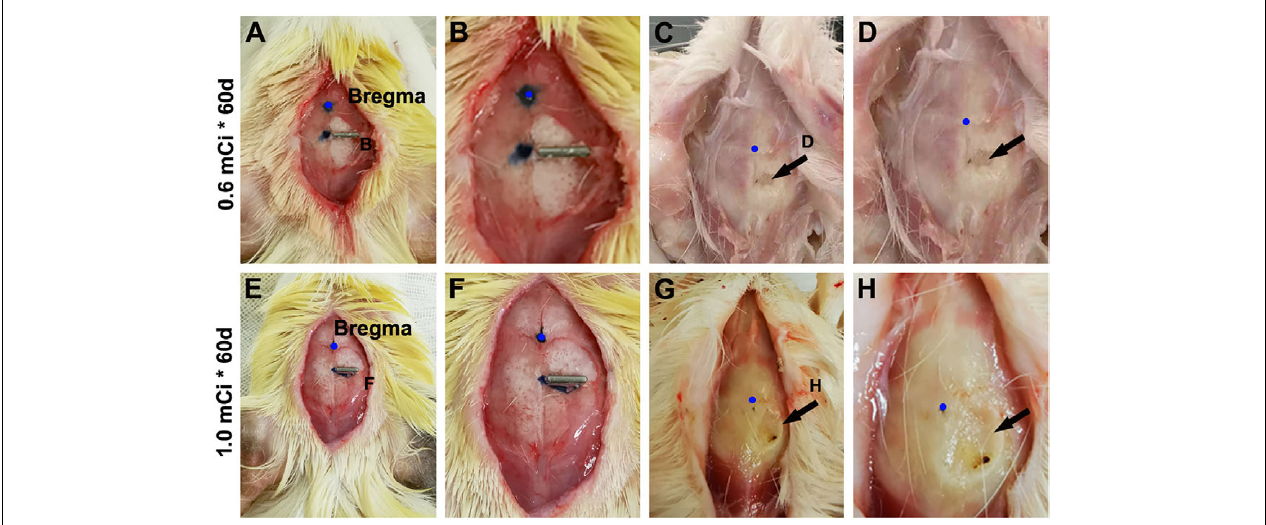
FIGURE 10 | Minor skull trauma around the 0.6- and 1.0-mCi 125 I seed after 60-day survival. The left panels (A,E) show the implantation location of the 125 I seeds. (B,F) Are enlarged views of the implant areas. (C,D,G,H) Show the views after brain perfusion and the 125 I seeds